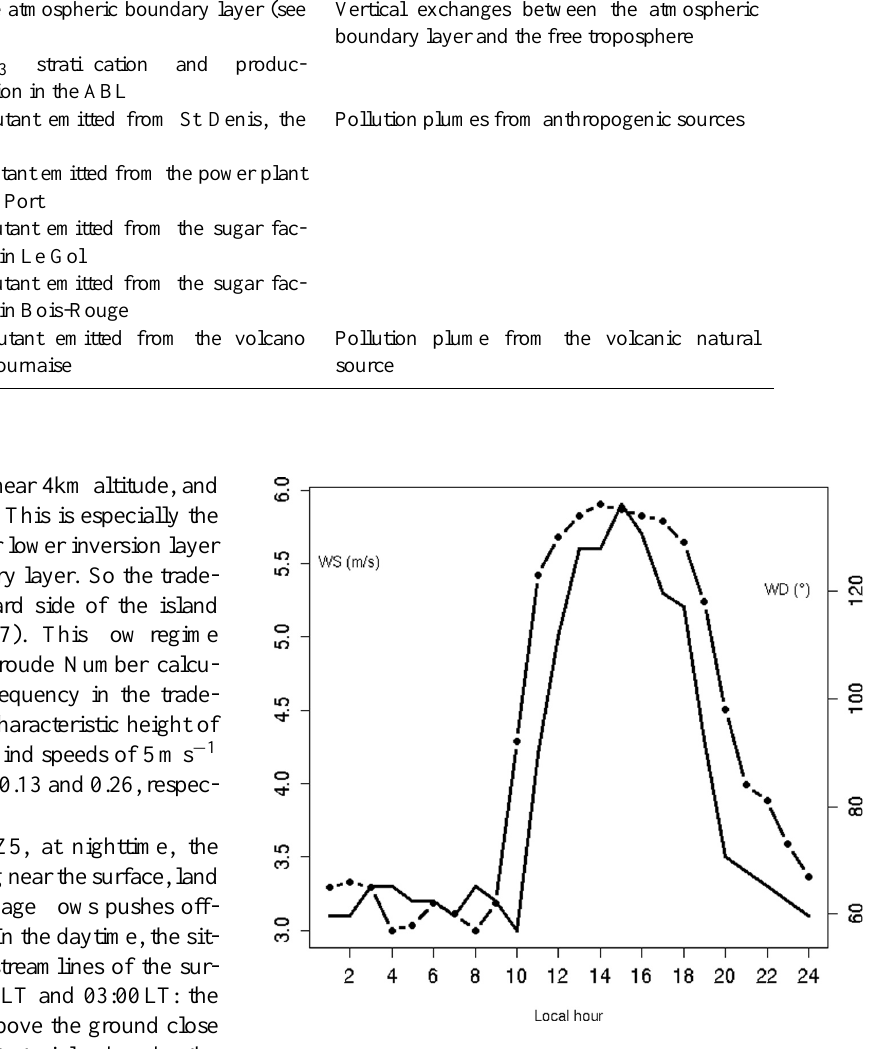
Fig. 7. Wind speed (solid line) and wind direction (dotted line) at Pierrefonds, obtained from averaged hourly observations (source: M´et´eoFrance) during the austral winter in